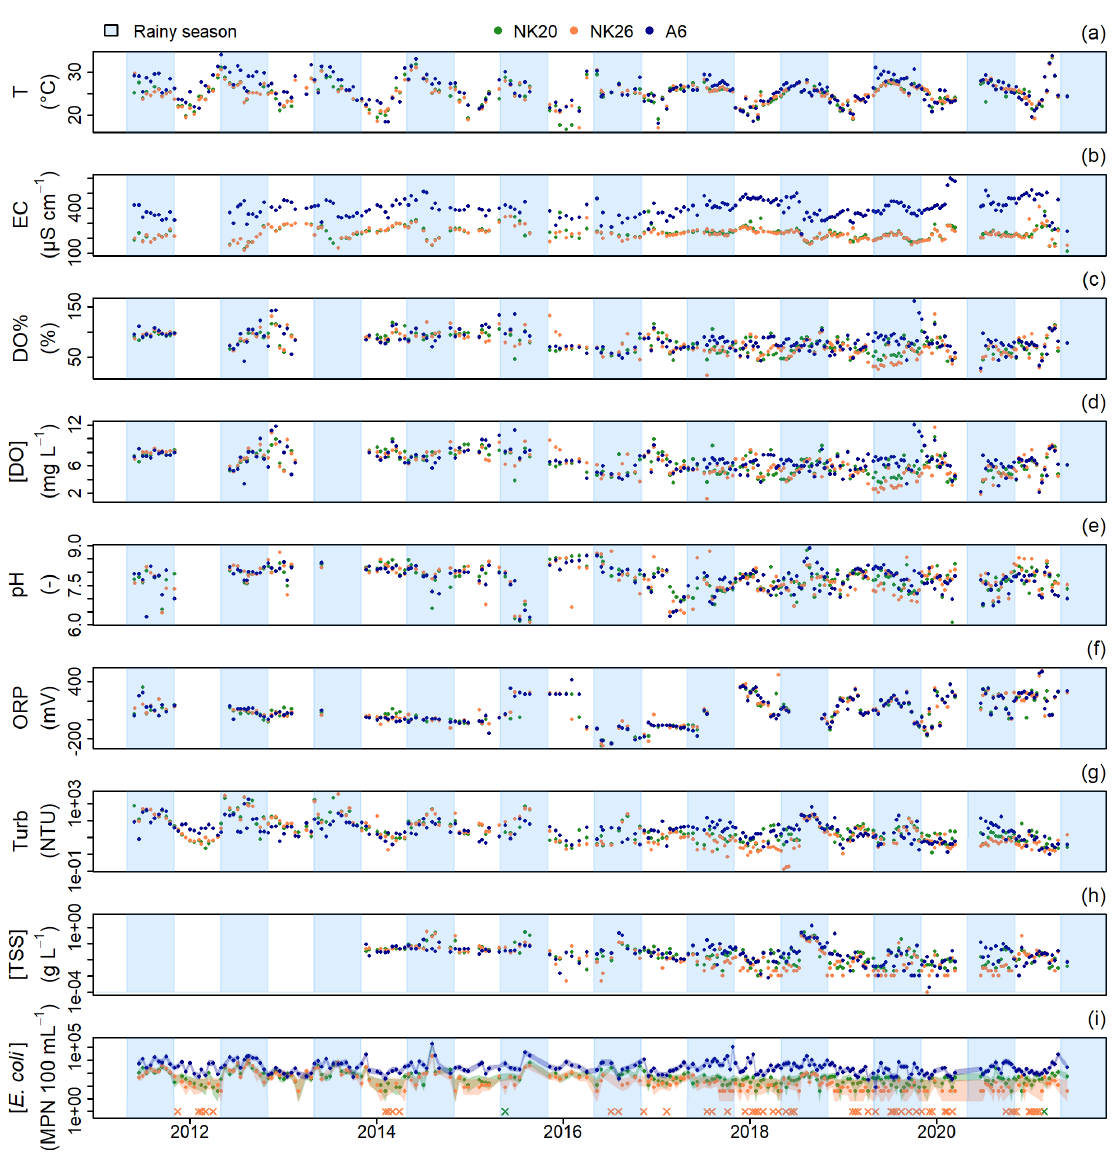
Figure 3. Stream water quality from 2011 to 2021 along the Nam Khan river (sampling stations NK20 and NK26) and its tributary Houay Khan (sampling station A6), northern Lao PDR. T : temperature ( ◦ C); EC: electrical conductance at 25 ◦ C (µScm − 1 ); DO%: oxygen satura- tion (%); [DO]: oxygen concentration (mg L − 1 ); pH: pH (–); ORP: oxidation-reduction potential (mV); Turb: turbidity (NTU); [TSS]: total suspended sediment concentration (gL − 1 ); [ E. coli ]: Escherichia coli concentration (MPN 100mL − 1 ) with lower and upper limits of